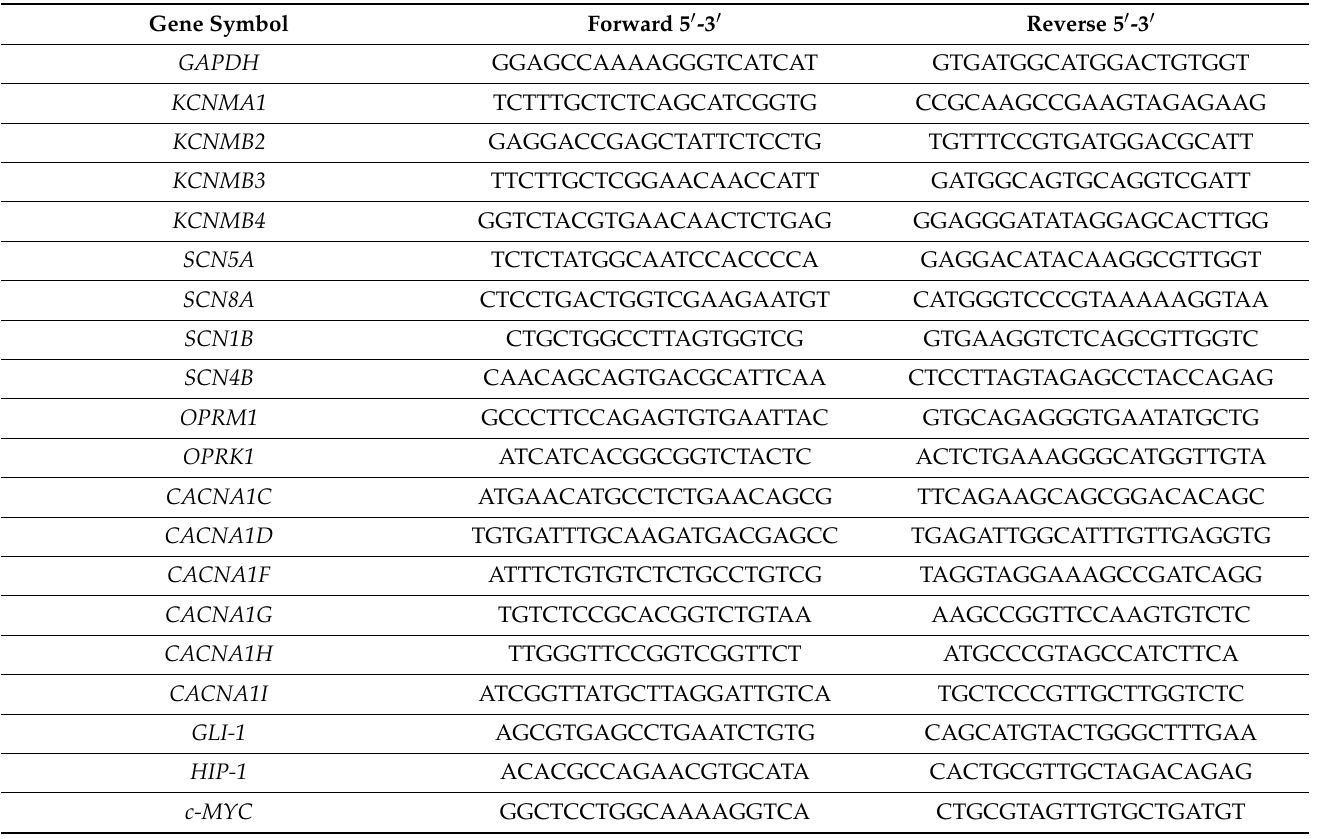
Table 1. The primers used in these